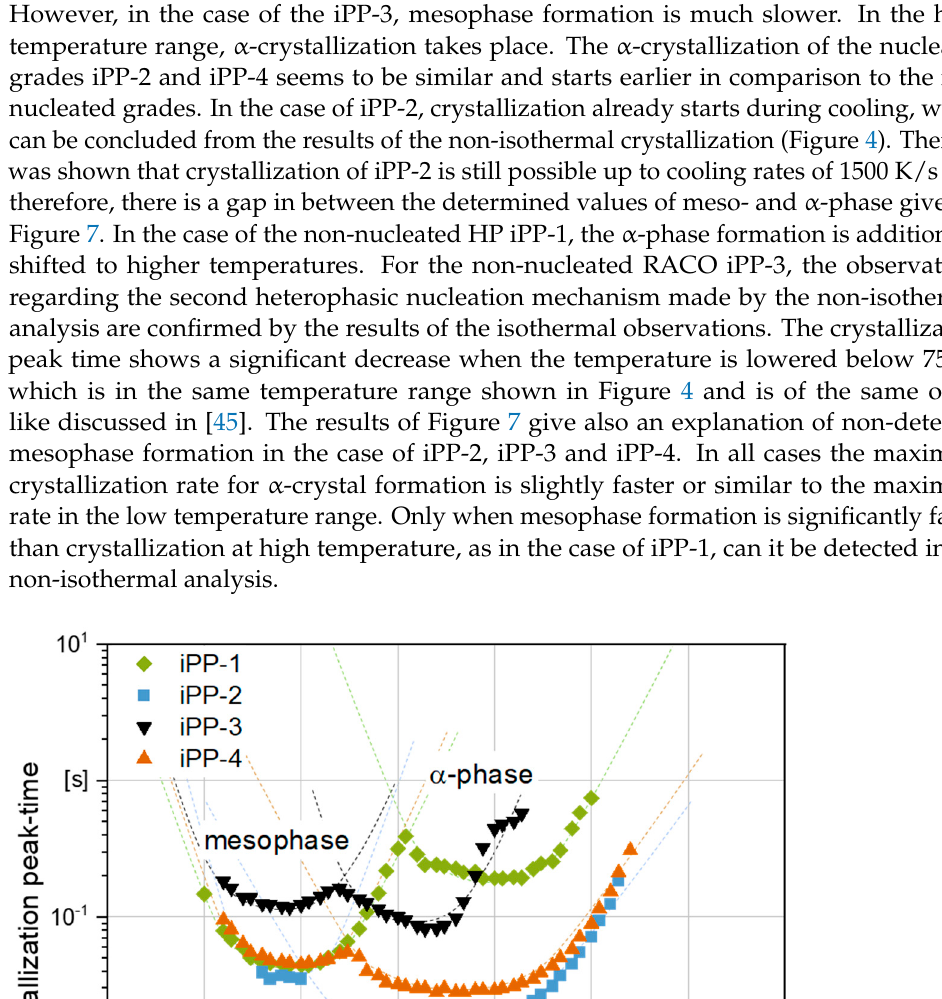
Figure 8. Micrographs of iPP homo- and copolymers at different isothermal crystallization temperatures analyzed by fast scanning chip calorimetry (FSC).